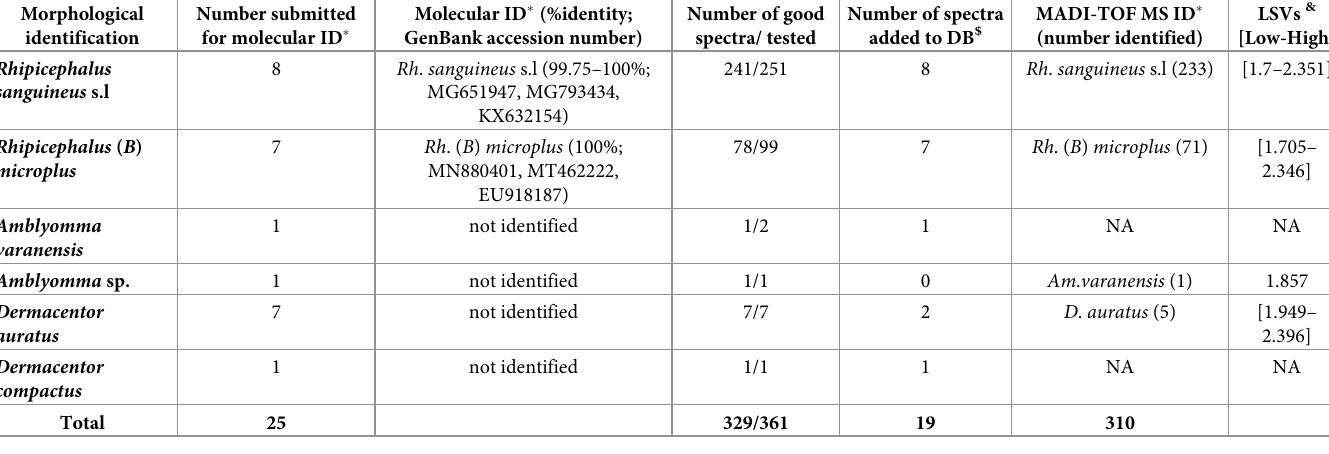
Table 2. The number of tick species used for MALDI-TOF MS analysis, creation of the MS reference spectra creation, and molecular biology confirmation. Morphological identification